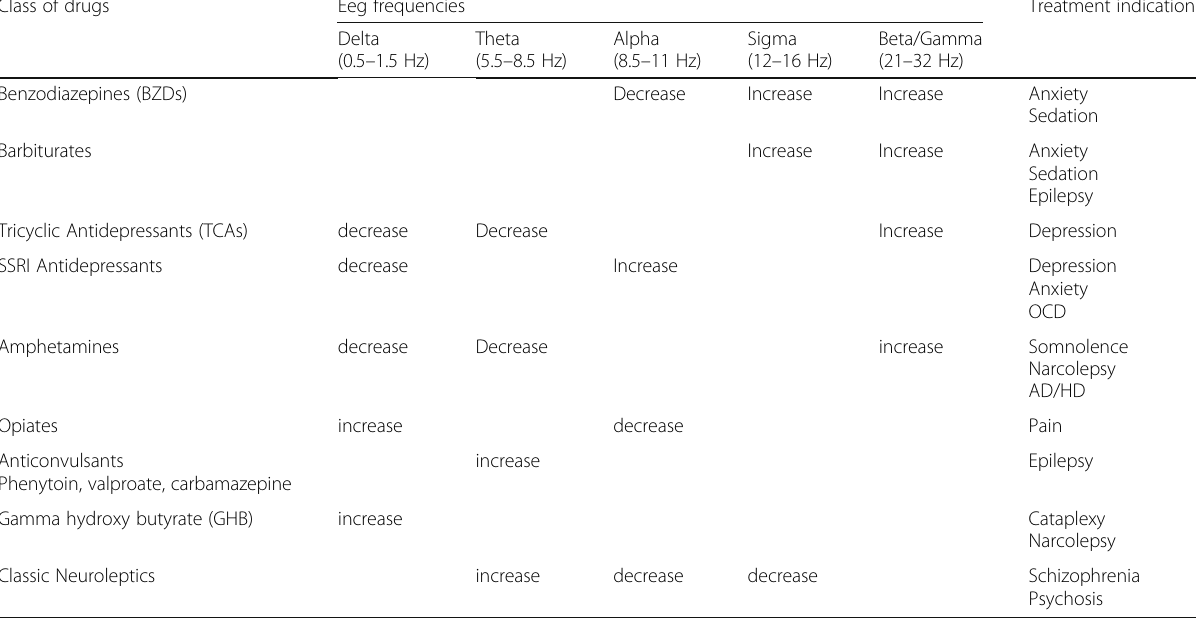
Table 2 Consistent quantitative alteration in physiologic EEG frequencies induced by psychoactive